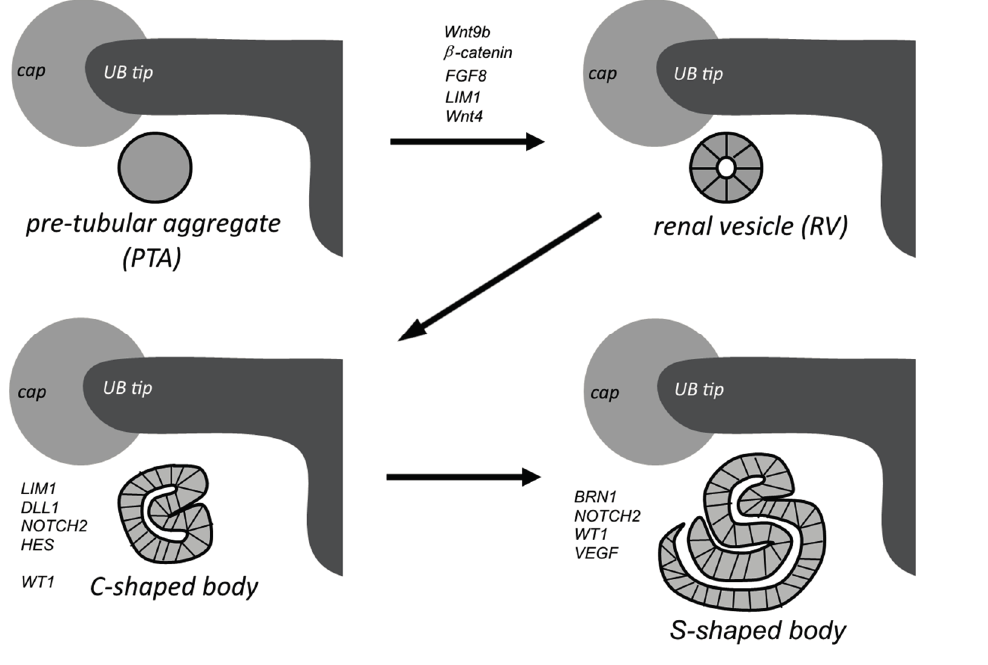
Figure 3. Kidney development stages. Top left: Stem/progenitor cells in the UB interact with the adjacent cap mesenchyme (CM) to form pre-tubular aggregates (PTA) just beneath the tip of the UB and differentiate into the renal vesicle (RV) (top right). Newly formed RVs undergo polarization and elongation to form Comma- (bottom left) and S-shaped (bottom right) bodies; the latter fuse with the UB tip epithelium to form the